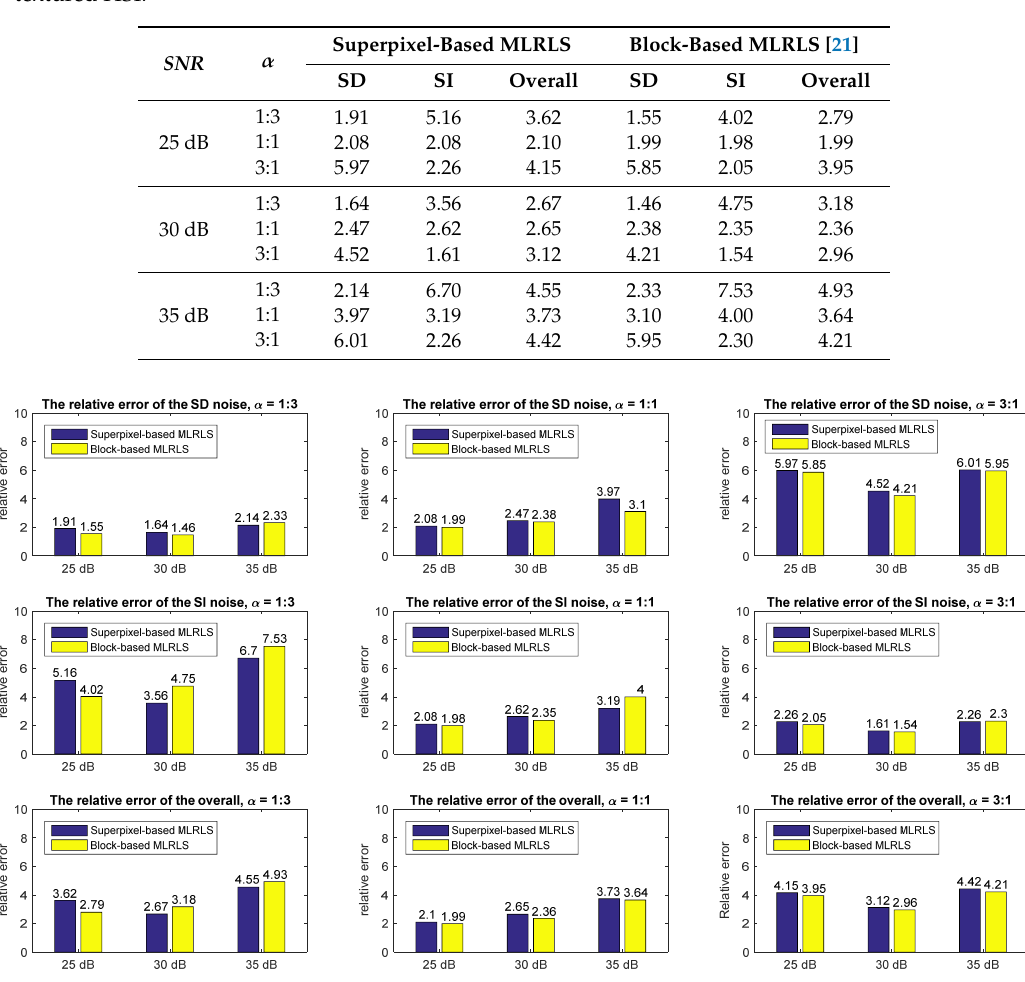
Figure 15. The optimal relative errors of the SD noise, the SI noise and the overall optimization for the textured HSI.